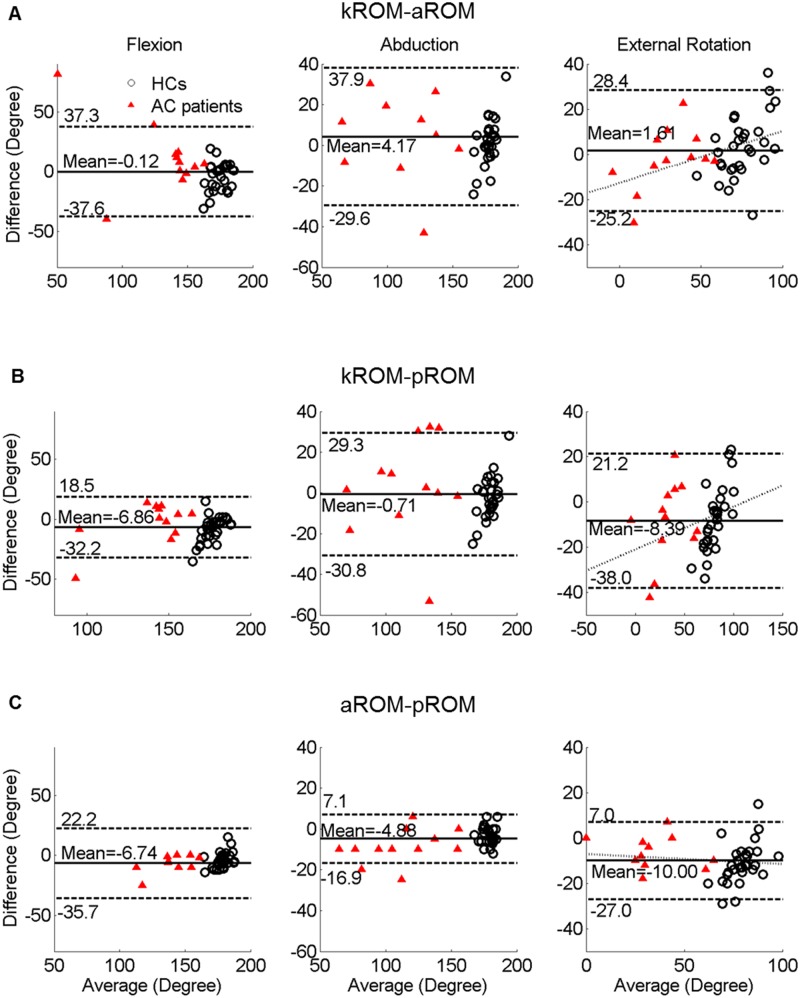
Bland-Altman plots of kROMs, pROMs, and aROMs.The circles show 30 shoulders of 15 healthy controls, while the triangles show 12 affected shoulders of patients with adhesive capsulitis (42 shoulders total). Mean differences are indicated by the solid line and 95% limits of agreement (mean differences ± 1.96 standard deviation of the difference) are shown by the dashed line. The dotted line shows regression lines for proportional biases. A. Comparison between kROMs and aROMs. B. Comparison between kROMs and pROMs. C. Comparison between aROMs and pROMs. kROMs, shoulder range of motion measured with the Kinect; pROMs, passive shoulder range of motion measured with the goniometer; aROMs, active shoulder range of motion measured with the goniometer.